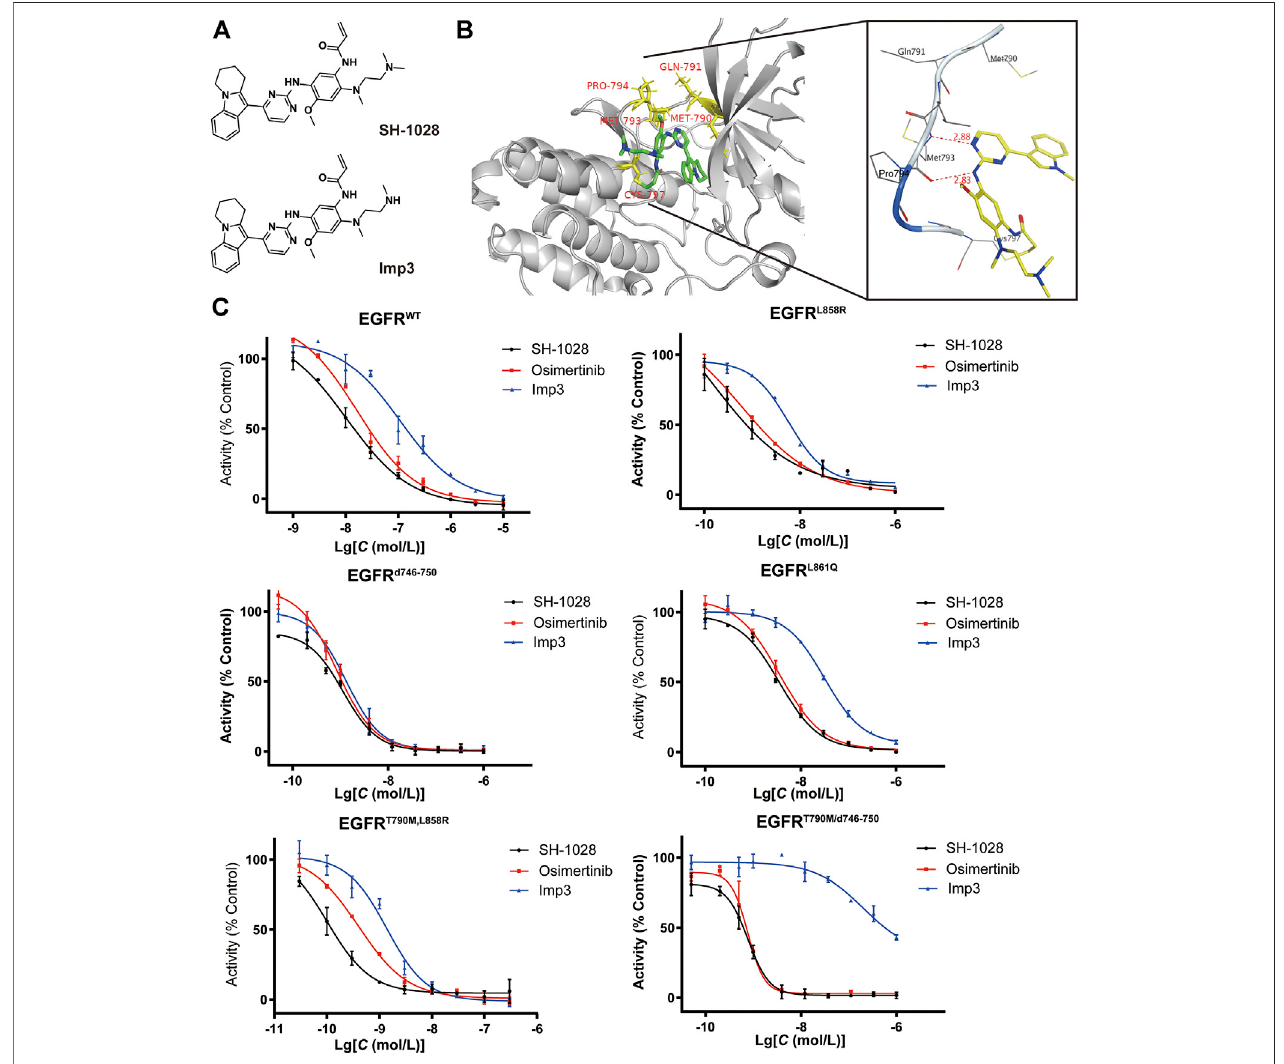
FIGURE 1 | Preliminary ef fi cacy of SH-1028. ( A ) Chemical structure of SH1028 and Imp3. ( B ) Docking structure of SH1028 to T790M EGFR. ( C ) kinase inhibition assay of SH-1028 in EGFR (WT, L858R, d746-750, L861Q, T790M/L858R, T90M/d746-750). Data were expressed as mean ± SD ( n (cid:1) 3).